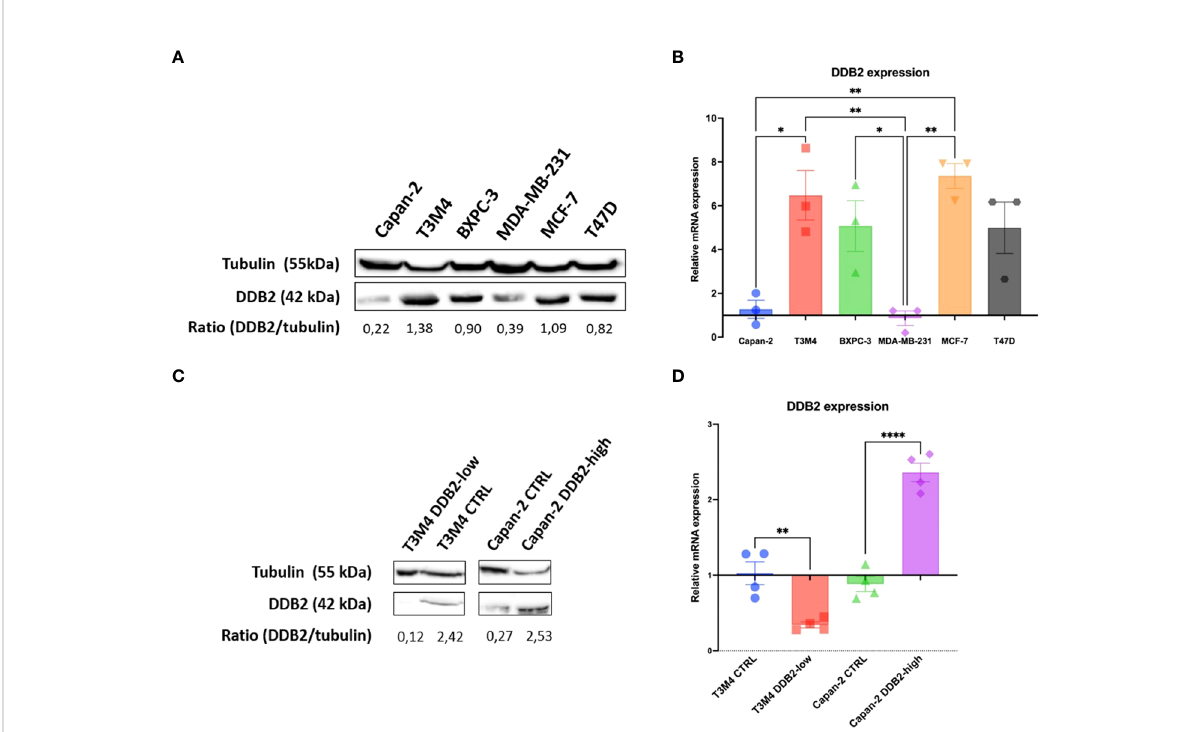
FIGURE 2 DDB2 expression in PDAC cell lines and in CRISPR-modi fi ed cell models. (A) DDB2 protein expression evaluated by western blot in three PDAC cell lines (Capan-2, T3M4 and BXPC3) compared to DDB2 high expressing (MCF-7 and T47D) and low expressing (MDA-MB-231) breast cancer cell lines. Tubulin was used as a loading control. (B) DDB2 mRNA expression assessed by RT-qPCR. b -actin was used as a housekeeping gene. Results were normalized using h-TERT-HPNE cell line. Data from 3 independent experiments are expressed as mean ± SEM, *p < 0.05, **p < 0.01 (ANOVA). (C) DDB2 protein expression determined by western blot in T3M4 CRISPR/Cas9 KO DDB2 cells (T3M4 DDB2-low), Capan-2 CRISPR activation DDB2 cells (Capan-2 DDB2-high) and CRISPR control cells (T3M4 CTRL and Capan-2 CTRL). Tubulin was used as a loading control. (D) DDB2 mRNA expression evaluated by RT-qPCR in T3M4 DDB2-low, Capan-2 DDB2-high, T3M4 CTRL and Capan-2 CTRL. b -actin was used as a housekeeping gene. Results were normalized according to DDB2 expression in T3M4 wild type and Capan-2 wild type cells respectively. Data